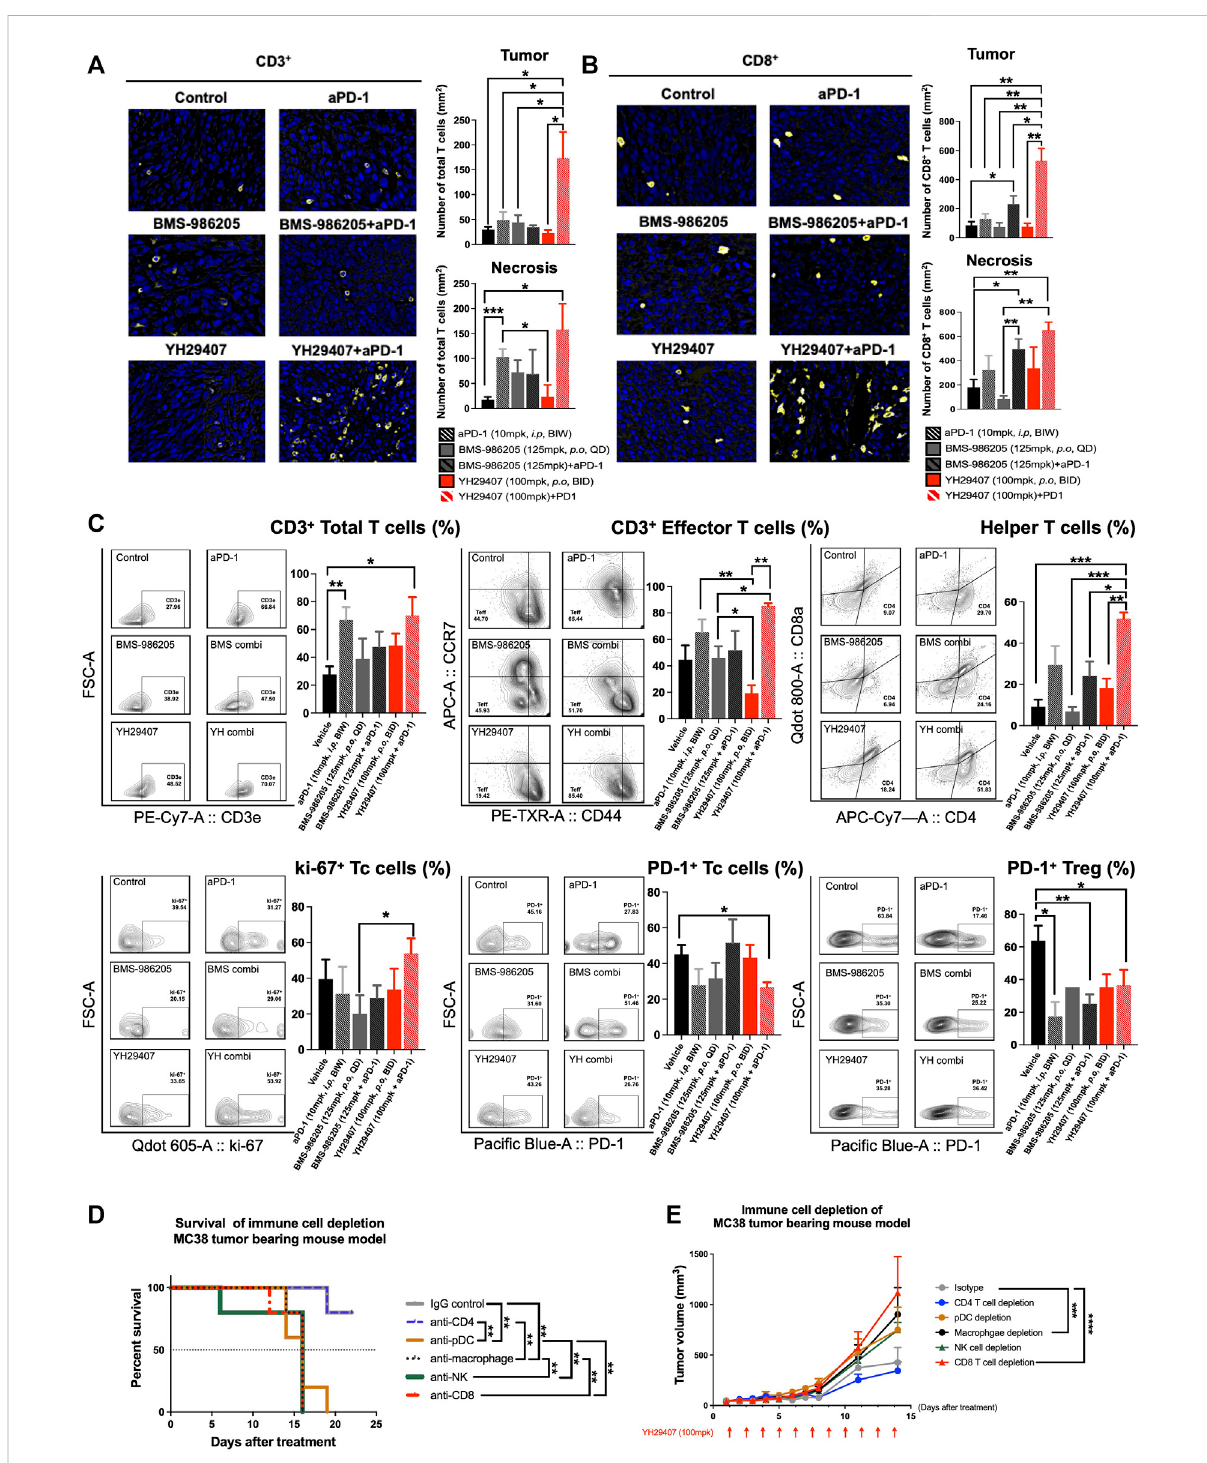
CombinationtreatmentofYH29407andaPD-1enhancedTcellactivation,particularlyeffectorTcellsandhelperTcells.In fi ltratedCD3 + Tcells (A) and CD8 + T cells (B) to the tumor were signi fi cantly enhanced in the YH29407+aPD-1 group compared to the other groups. (C) Total T cells, effectorTcells,helperTcells,andki-67+Tccellsweresigni fi cantlyincreasedintheYH29407+aPD-1group.However,PD-1+TccellsandTregwere decreased in the YH29407+aPD-1 group compared to the control and other groups. Immune cell depletion affected survival (D) and tumor growthinMC38tumor-bearingmice (E) .Statisticalsigni fi cancebetweengroupswascalculatedusingtwo-wayANOVAfollowedbyTukey ’ smultiple comparisons testor student ’ st-test(* p < 0.05, ** p ≤ 0.01, *** p ≤ 0.001, **** p ≤ 0.0001). Tc,cytotoxic Tcell; Treg, regulatory Tcell; ANOVA, analysis of